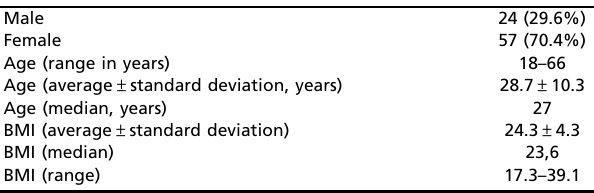
Table 1 - Patient demographics.